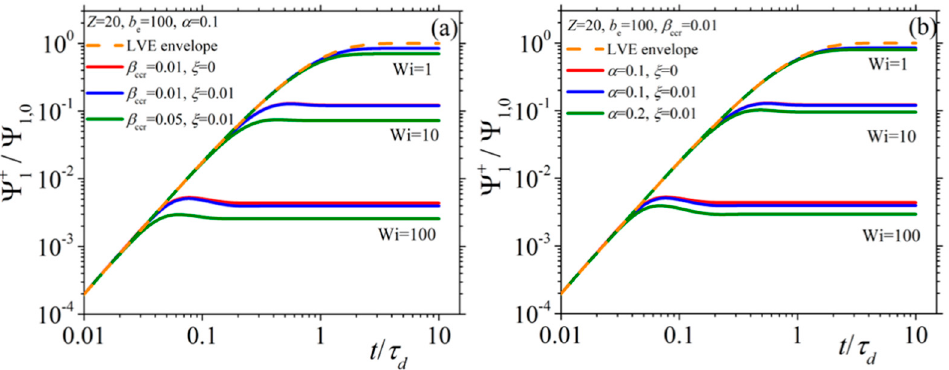
Figure 3. Same as with Figure 2 but for the first normal stress coefficient when ( a ) keeping α constant, and ( b ) keeping β ccr constant.